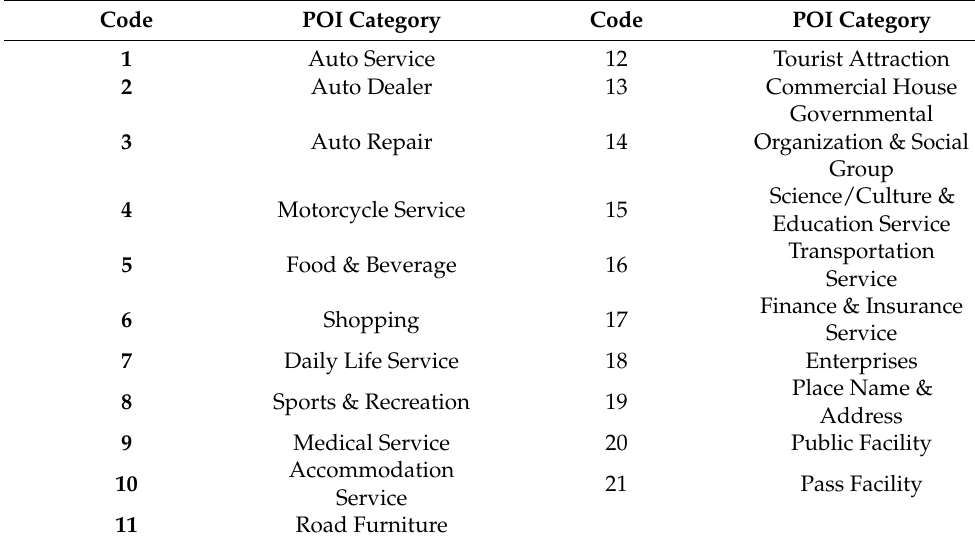
Table 1. POI category